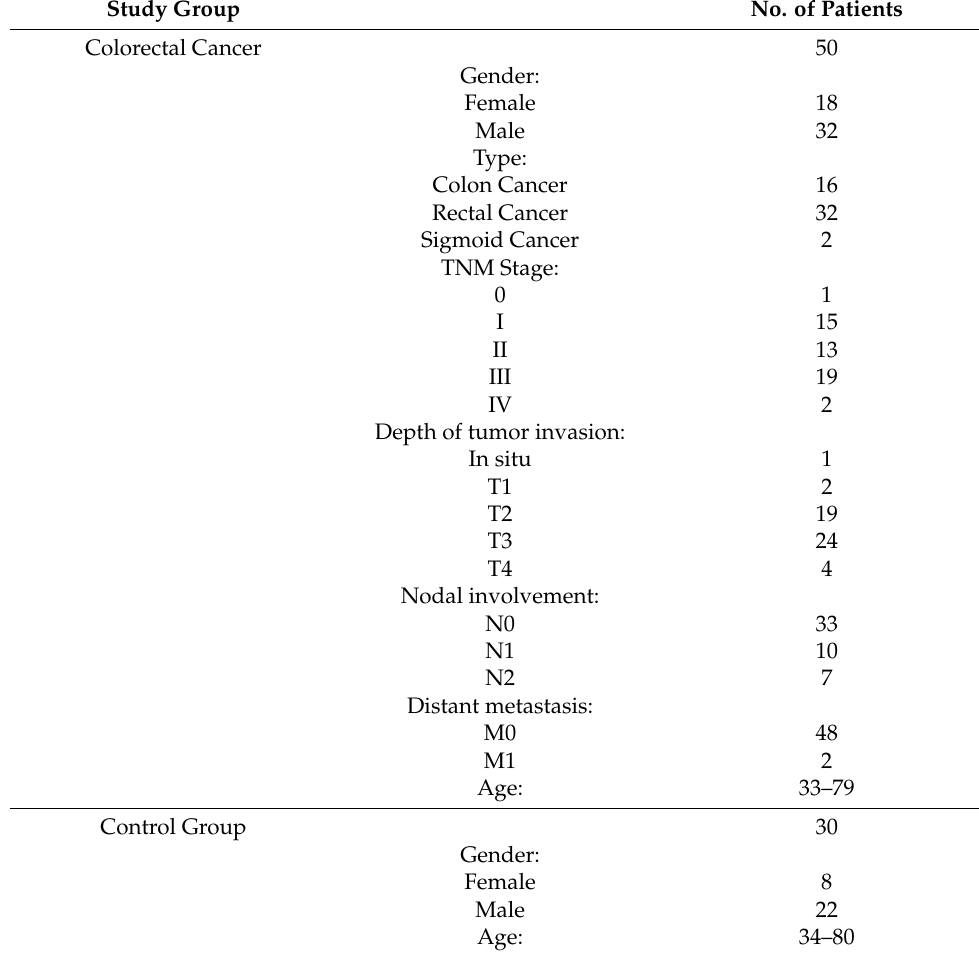
Table 4. Characteristics of colorectal cancer and healthy patient groups. Study